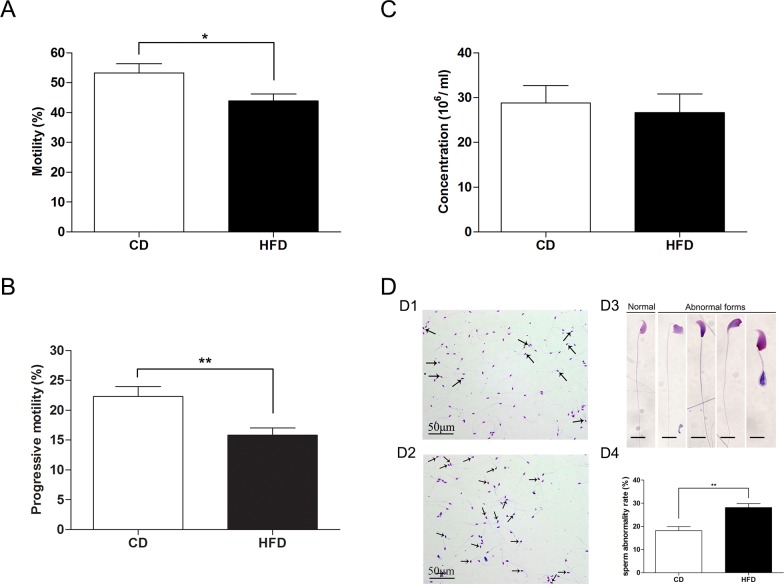
Comparison of sperm function parameters in mice fed either CD or HFD.(A) Sperm motility in mice fed either CD or HFD analyzed by CASA. (B) Sperm progressive motility in mice fed either CD or HFD analyzed by CASA. (C) Sperm concentration from cauda epididymis in mice fed either CD or HFD analyzed by CASA. (D) Sperm morphology analysis of CD-fed mice (D1) and HFD-fed mice (D2) using Diff-Quick method. Arrows indicate abnormal spermatozoa. Scale bar = 50 μm. (D3) Normal and abnormal spermatozoa in different forms, Scale bar = 10 μm. (D4) Comparison of sperm abnormality in mice fed either HFD or CD. Data are expressed as mean ± SEM. *P<0.05, **P<0.01.